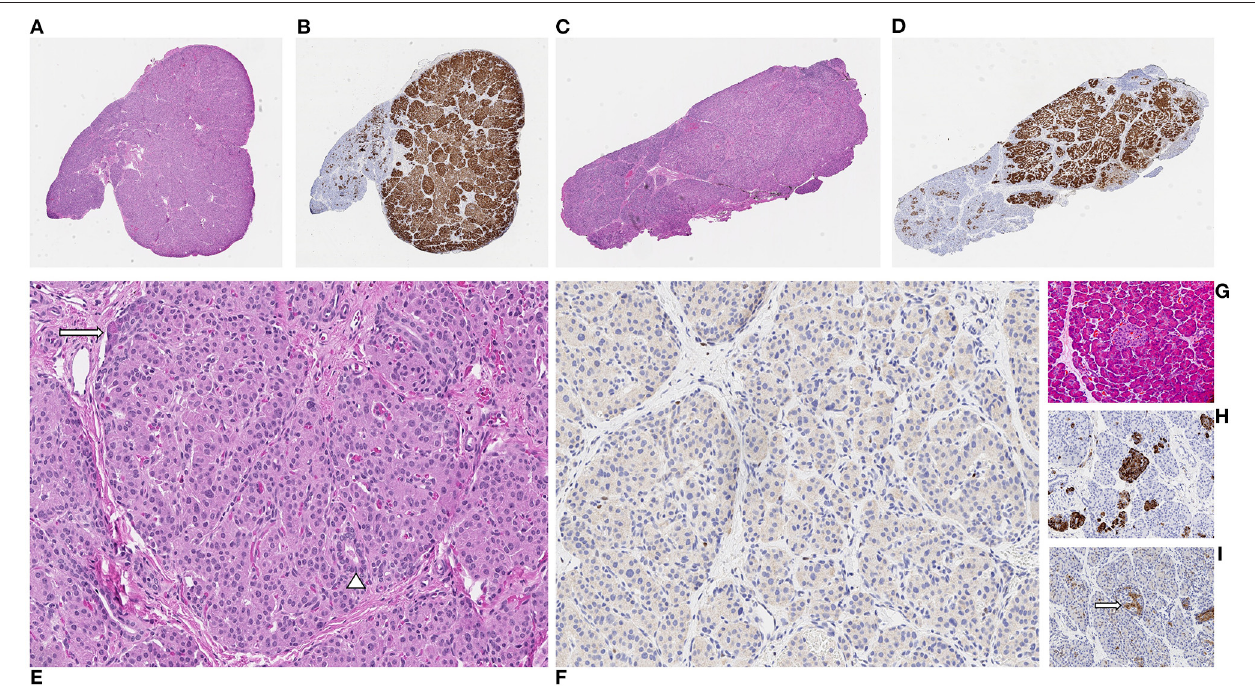
FIGURE 3 | Patient 2. Two distinct focal lesions arising in the pancreatic head (A,B) and body (C,D) each demonstrating localized increases in endocrine tissue which are highlighted on chromogranin immunohistochemical (IHC) stain [ (A,C) hematoxylin and eosin [H&E], (B,D) chromogranin IHC, all at x20 original magnification]. Higher-power magnification of head lesion demonstrating increased endocrine cells with rare intermixed acinar cells (arrow) and small ducts (arrowhead) [ (E) H&E, x200 original magnification] with loss of nuclear p57 immunoreactivity within lesional cells [ (F) p57 IHC, x200 original magnification]. Compared to lesional areas, normal pancreatic tissue shows relatively small islets (arrow) composed of endocrine cells which are positive for chromogranin but with retained nuclear p57 immunoreactivity; non-specific p57 immunoreactivity is observed within the cytoplasm [ (G) H&E, (H) chromogranin IHC, (I) p57 IHC, all at x200 original